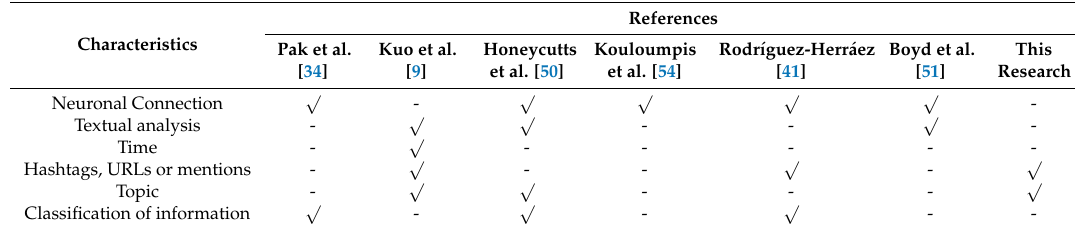
Table 4. Characteristics of Sentiment Analysis in investigations.